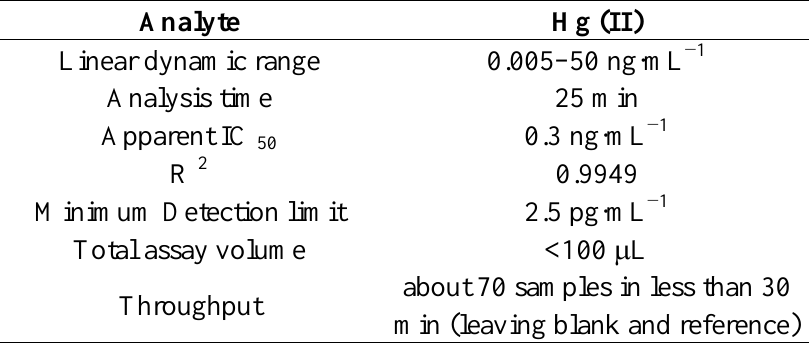
Table 2 . Figures of merit for proposed Hg(II) assay in 96 well plate